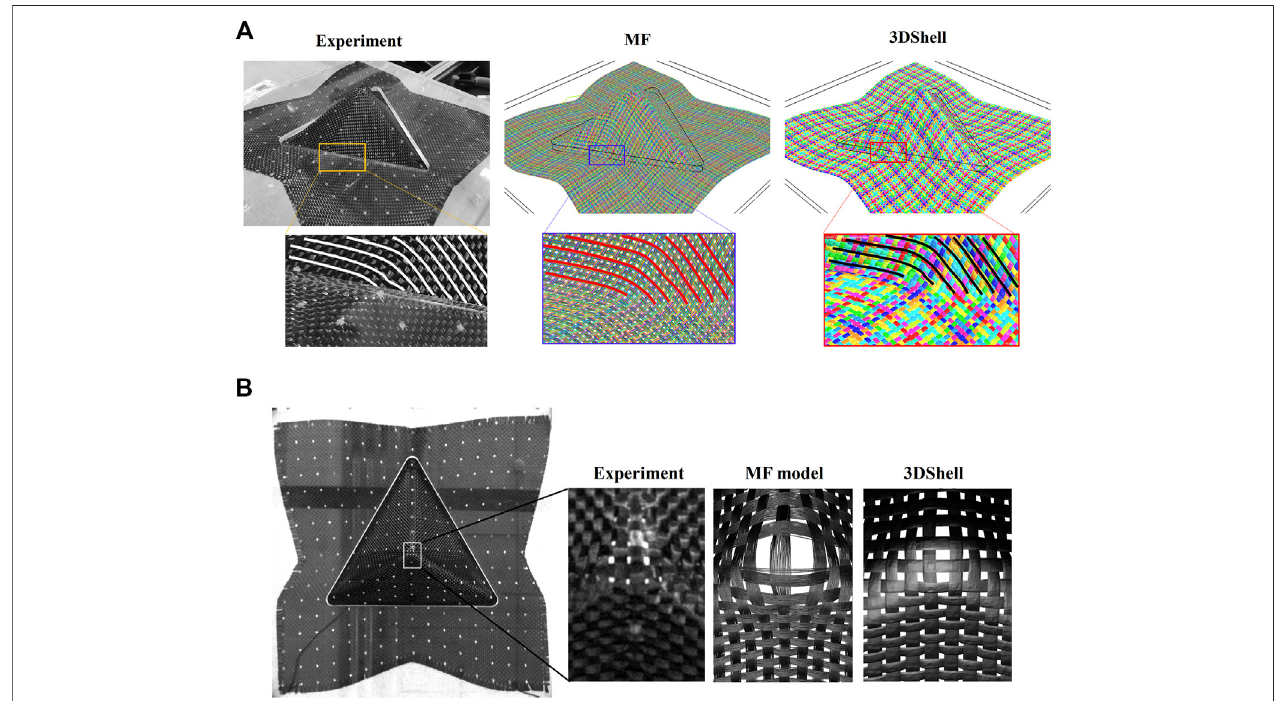
FIGURE8| Closeupimageoftheformedfabricinexperiment,theMFmodelandthe3DShellmodelintetrehefronformingat (A) shapetransisitonregionand (B) at the apex of the mould.